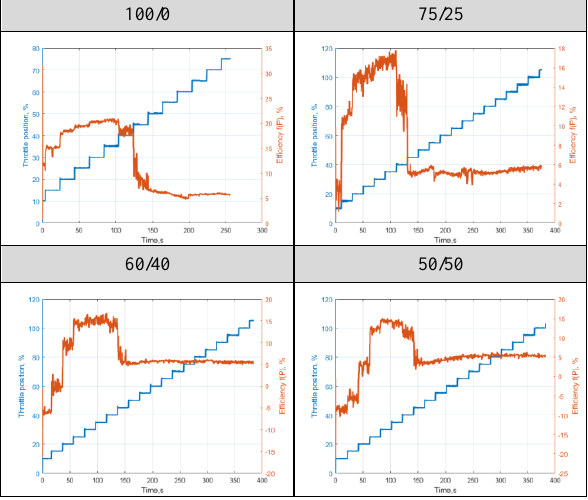
Fig. 13. Electricity generating system efficiency at supply of different gas mixture